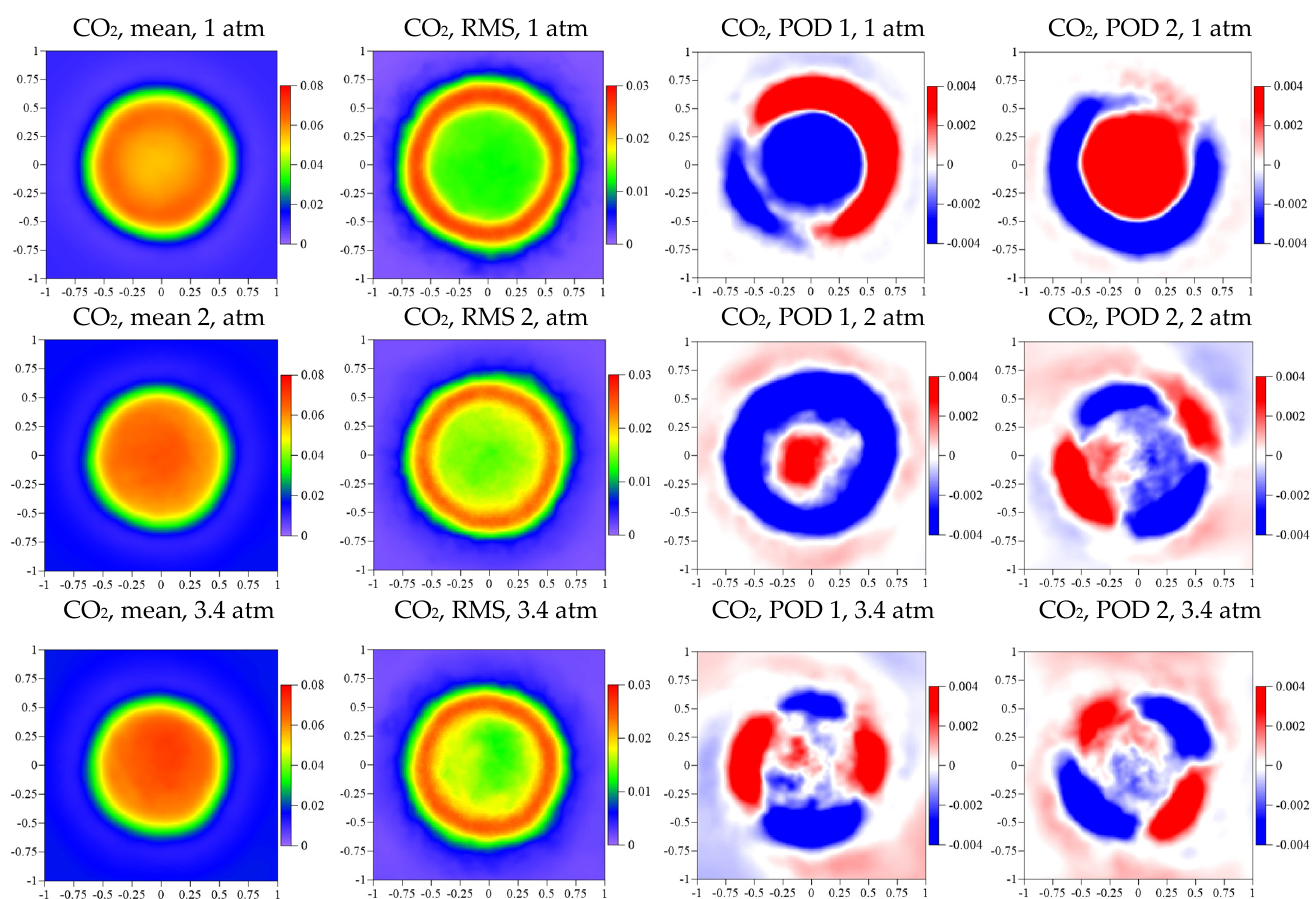
Figure 19. Mean and variation in the CO concentration field and the first and second POD modes.